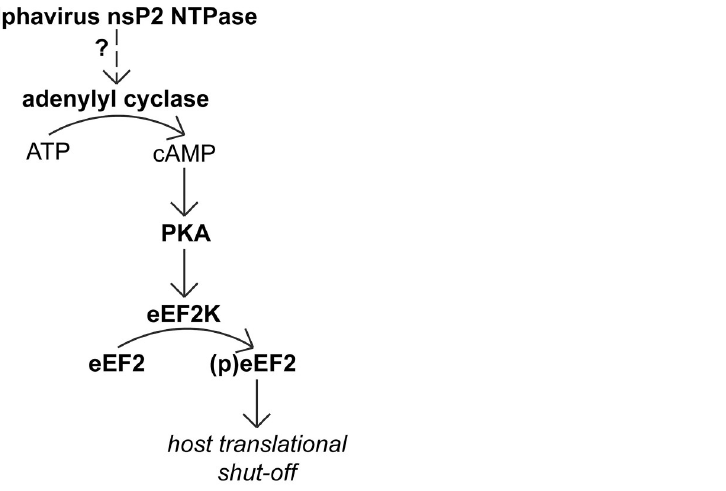
Fig 10. Proposed model for eEF2 phosphorylation during alphavirus infection. The NTPase activity of alphavirus nsP2 induces an increase in the intracellular cAMP concentration which results in activation of PKA and increased eEF2K activity, increased phosphorylation of eEF2 on T56 and T58 and inhibition of translation which contributes to the host shut-off during